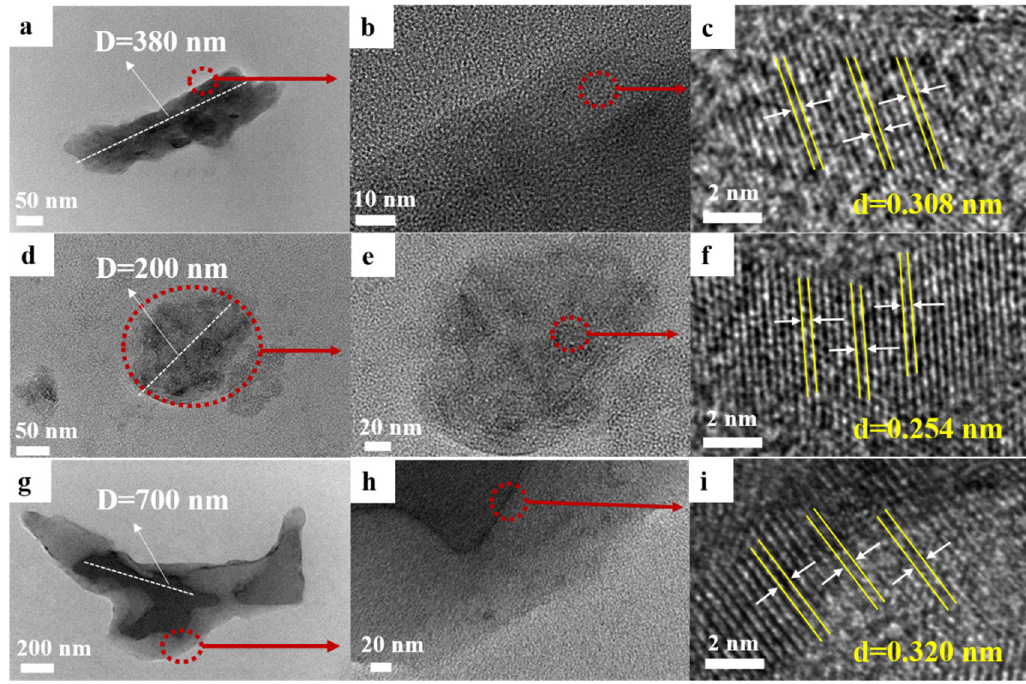
Figure 8. Morphological and crystalline structures of CLCCs in fluorescent fibers. HR-TEM im-